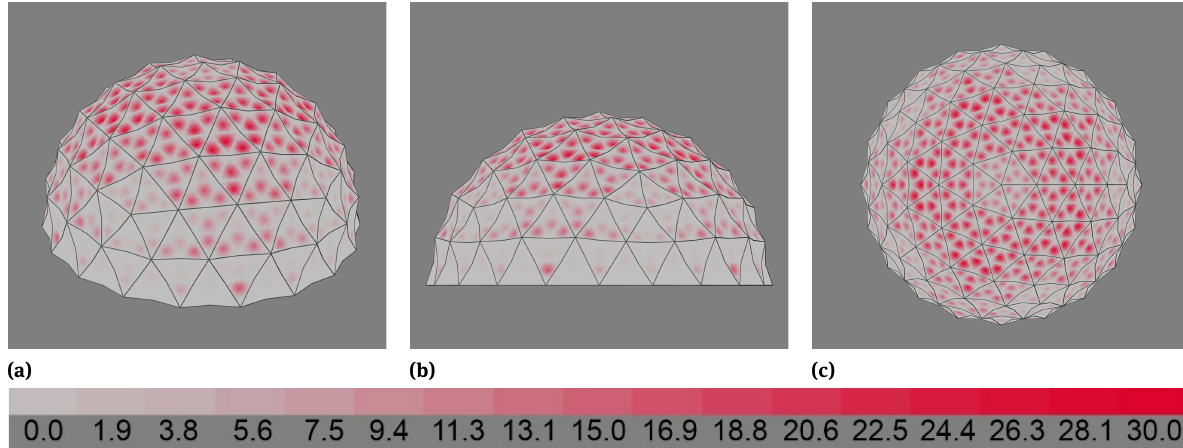
Figure 15: Fabric under the snow load (1.5 kN/m 2 ); a) 3D view, b) Side view, c) Top view. Maximum displacement: 27.67 cm